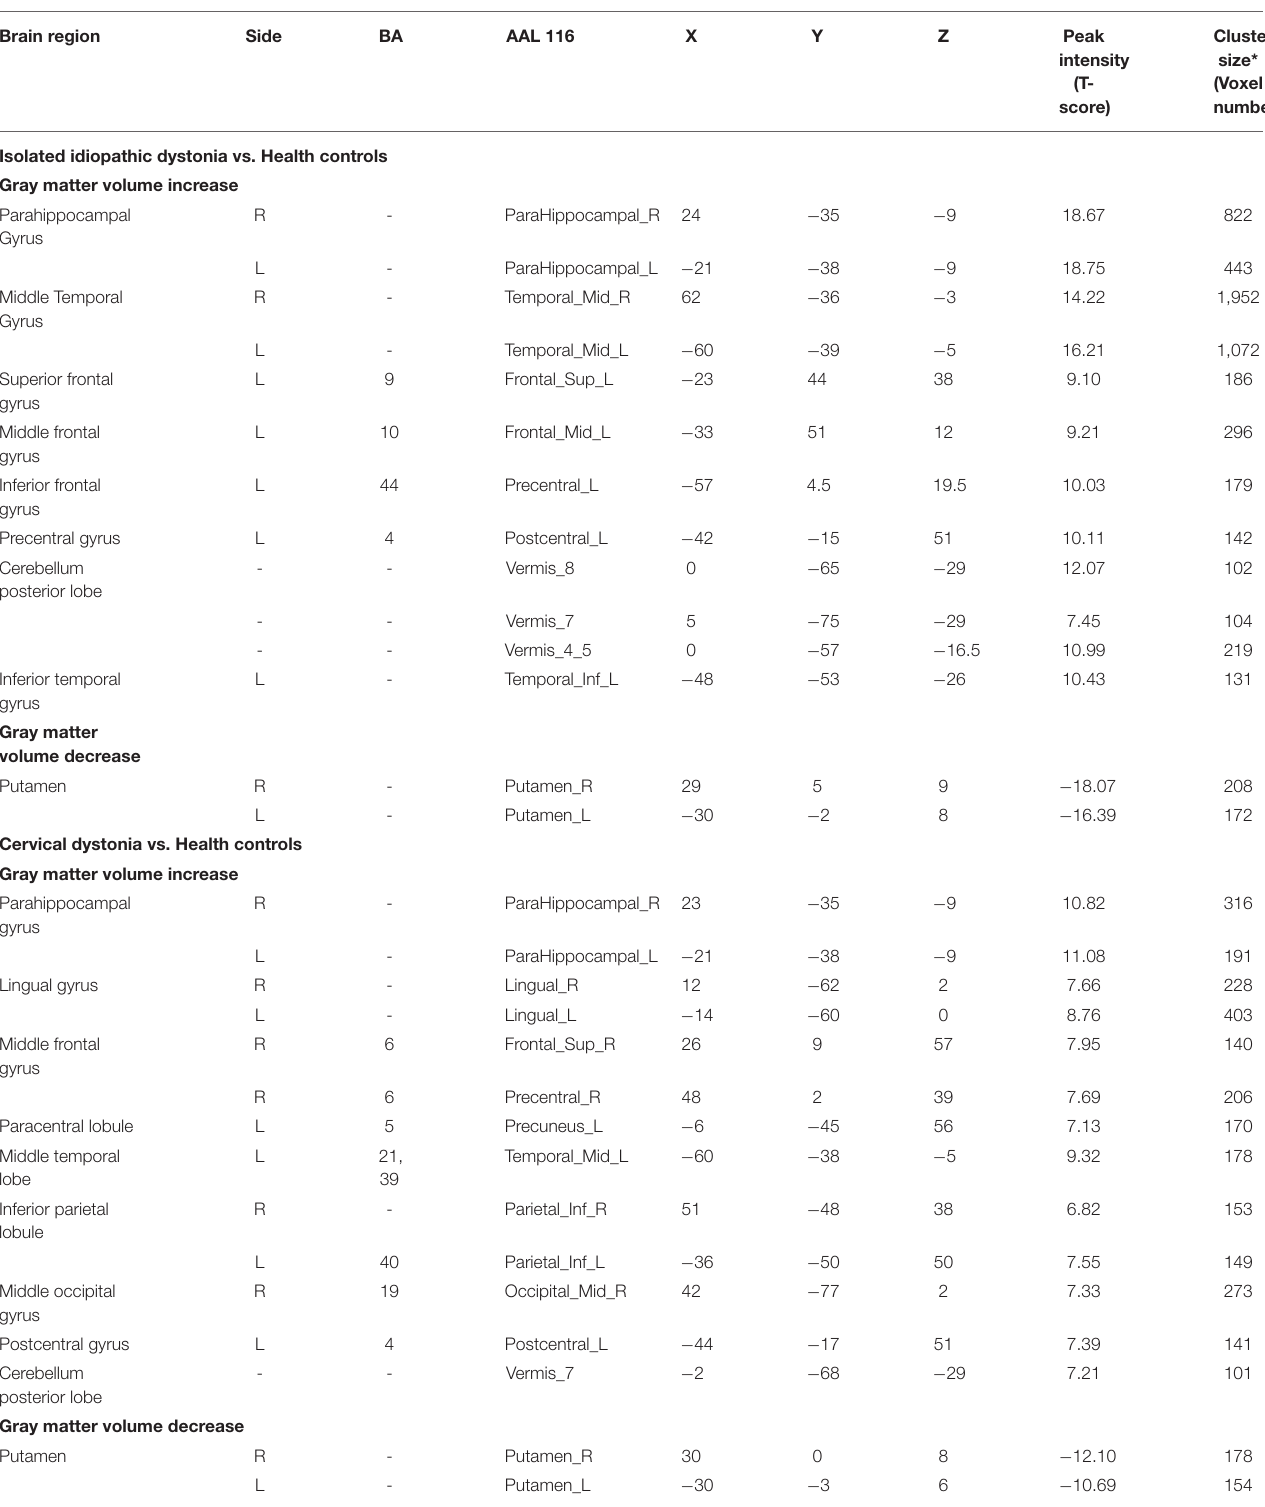
TABLE 3 | Gray matter volume changes in the whole group and subgroups (cervical dystonia, Meige syndrome, multifocal dystonia, and generalized dystonia) of Isolated idiopathic dystonia, compared with healthy controls ( P FWE < 0.005 at cluster